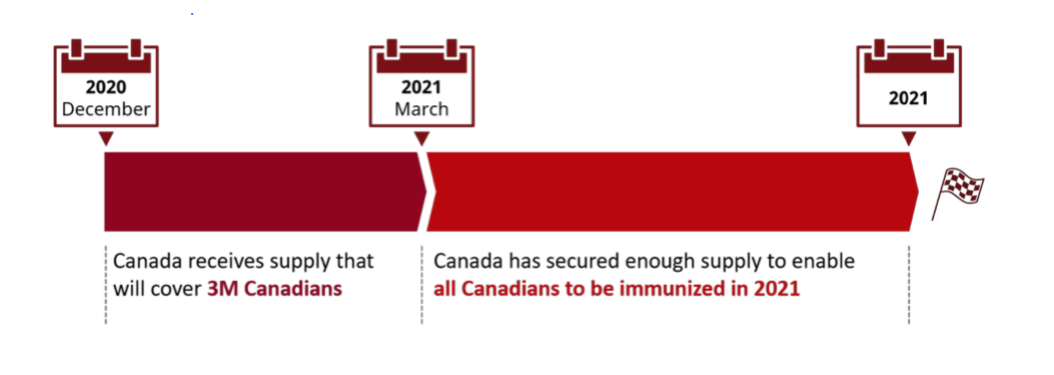
Figure 4. The Federal Government vaccine roll-out plan, adapted from